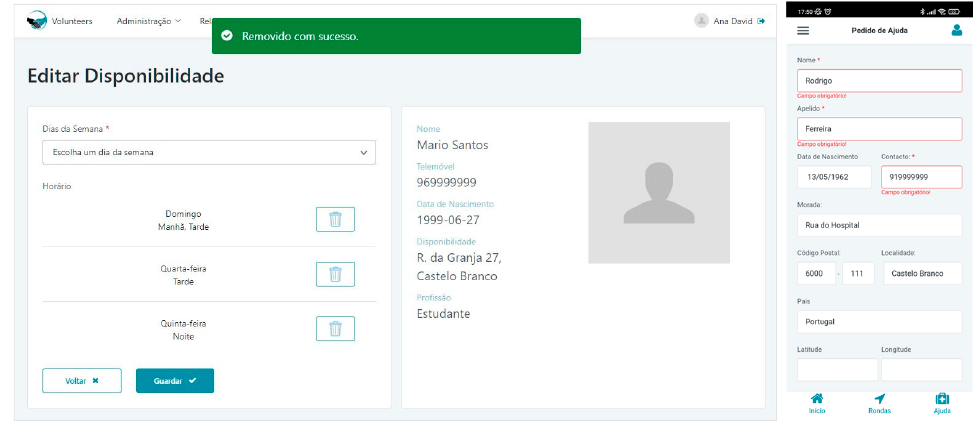
Figure 5. Backoffice ( left ) and App ( right ) interfaces.